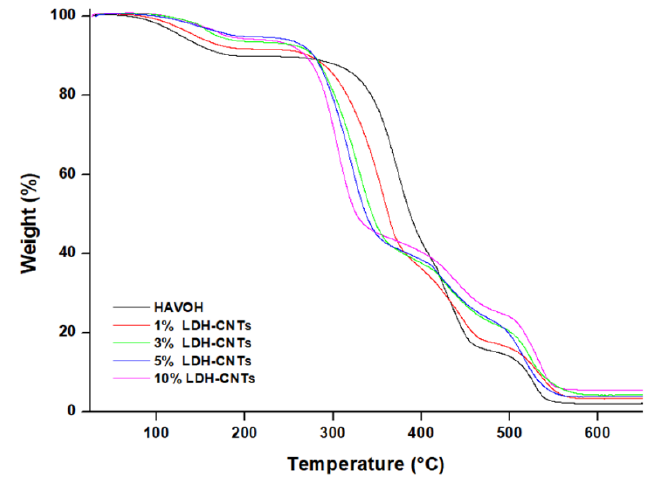
Figure 6. TGA curves for all the composites and the unfilled polymer.